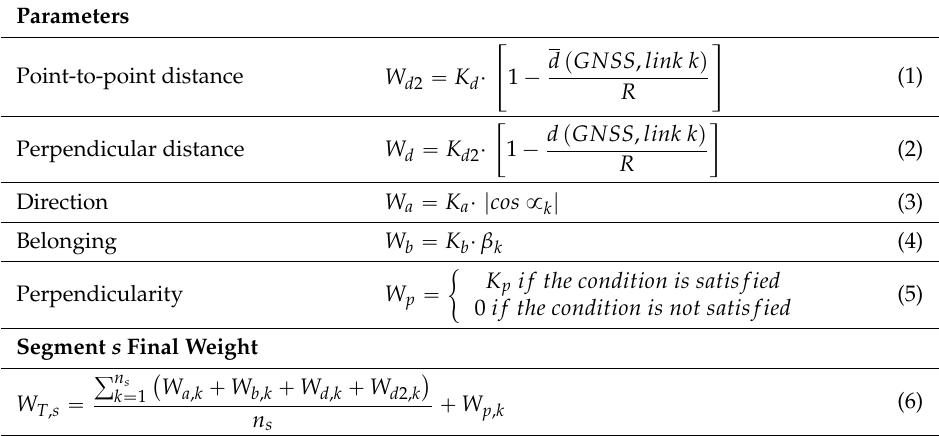
Table 1. Parameters included in the map-matching